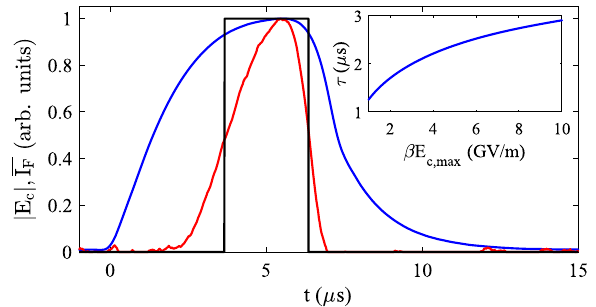
FIG. 8. Blue line: The normalized cathode field amplitude j E ð t Þj measured by the rf pickup. Red line: The predicted c average emission current I F ð t Þ by Eq. (3). Black line: The square pulse approximation of the emission profile. Inset: The width of the square emission profile as a function of β E c;